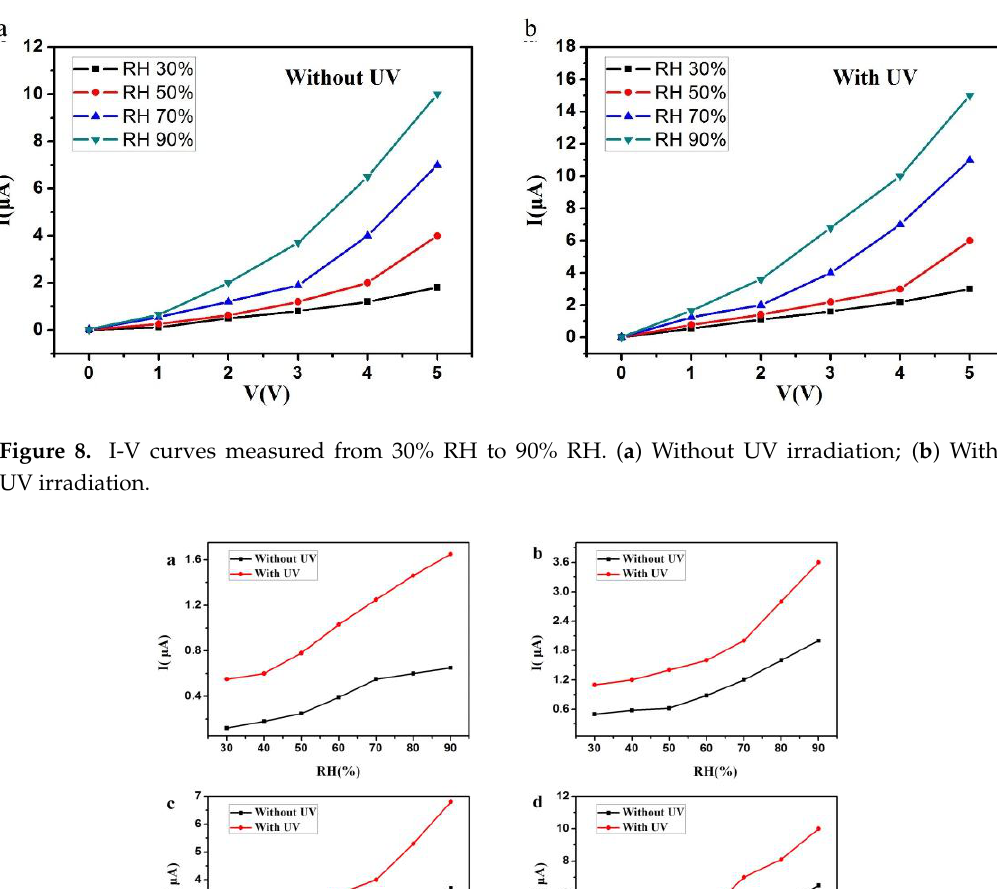
Figure 7. The reflectance spectrum for flat and Si nanopillar substrates.